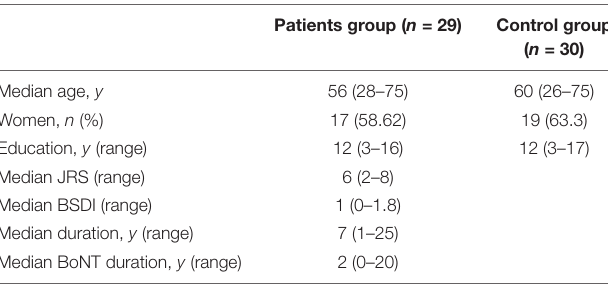
TABLE 1 | Subjects demographics and clinical